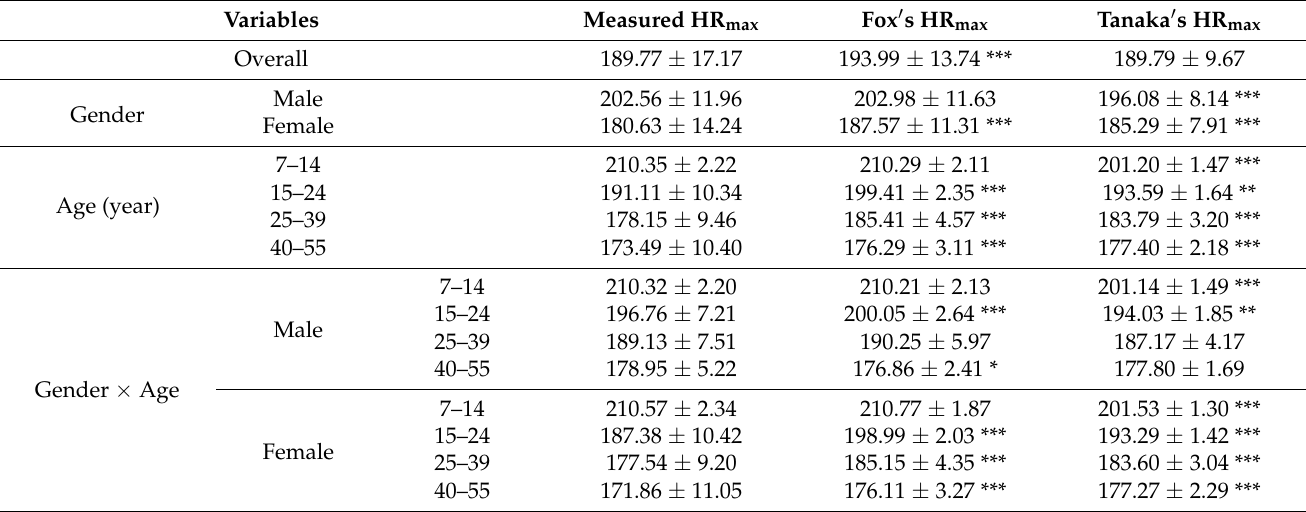
Table 2. Average of HR max divided by gender, age, and gender × age in each different HR max equation (Mean ±